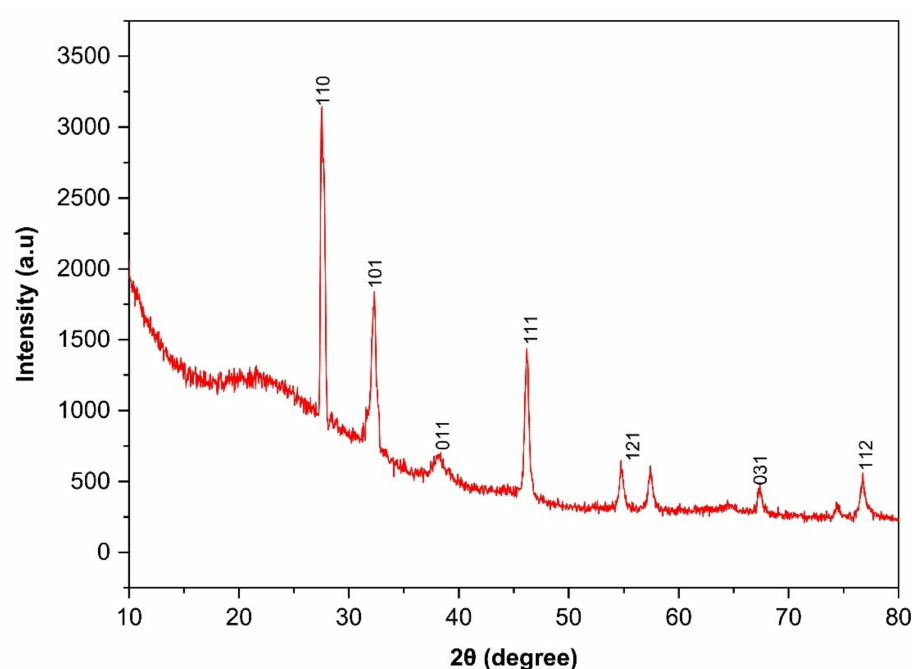
Figure 3. XRD spectra of TiO 2 NPs prepared by green